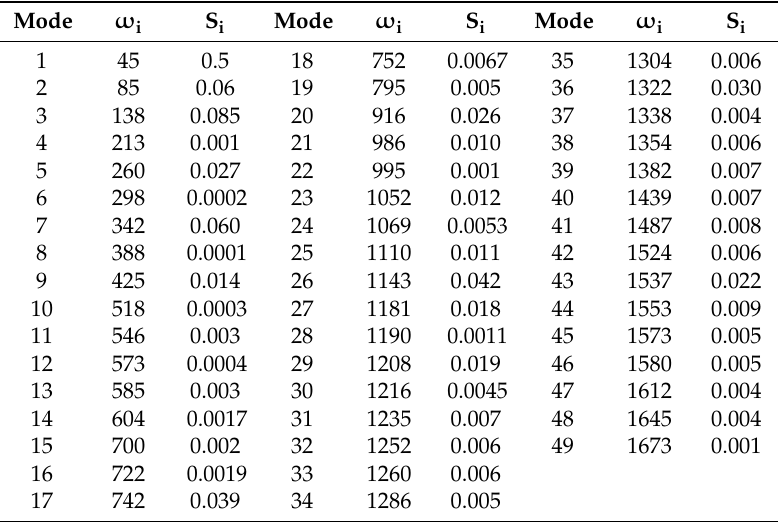
Table A1. Set of parameters that is necessary to simulate a realistic absorption spectrum in terms of Brownian oscillator model in the region of the chlorophyll Qy band., In addition to ω i and S i listed in the table, the damping factors γ i are required for each of the 49 modes. γ 1 = 30 cm − 1 , γ 2 = 7 cm − 1 ; all others are γ 3...49 = 5 cm − 1 .